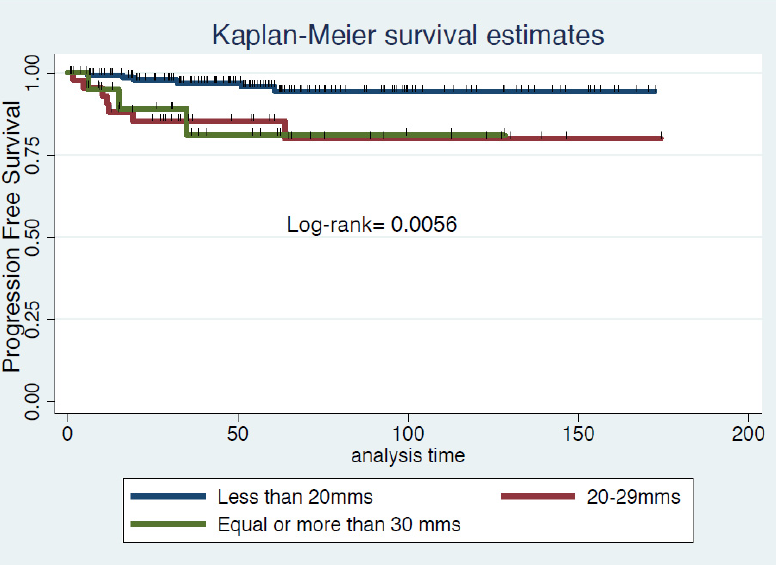
Figure 1. Progression-free survival in both groups. Kaplan–Meier estimates. log Rank: 0.011.